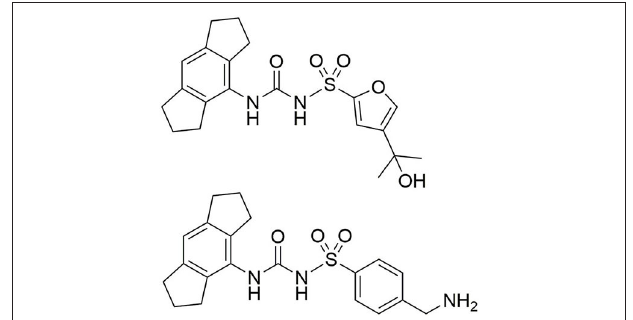
FIGURE 2 | Structure of CRID3 (MCC950, CP-456,773) with a substituted furan moiety (top) and an analog structure with a benzylamine moiety as flexible exit vector